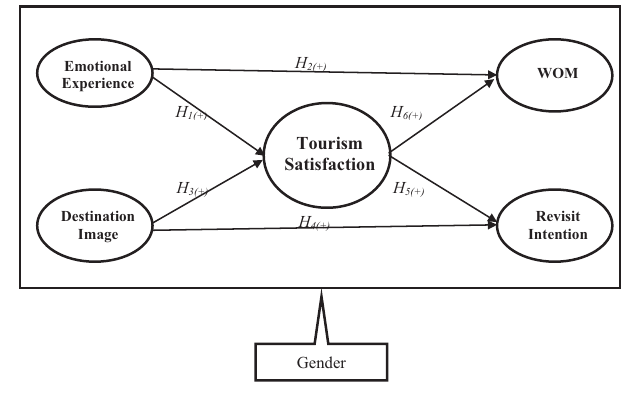
Figure 1. Proposed